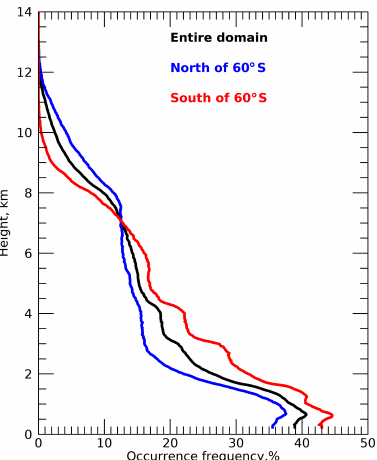
Figure 2. Mean vertical distributions of total clouds derived from ARM radar–lidar observations with a 5min temporal resolution and a 30m vertical resolution during